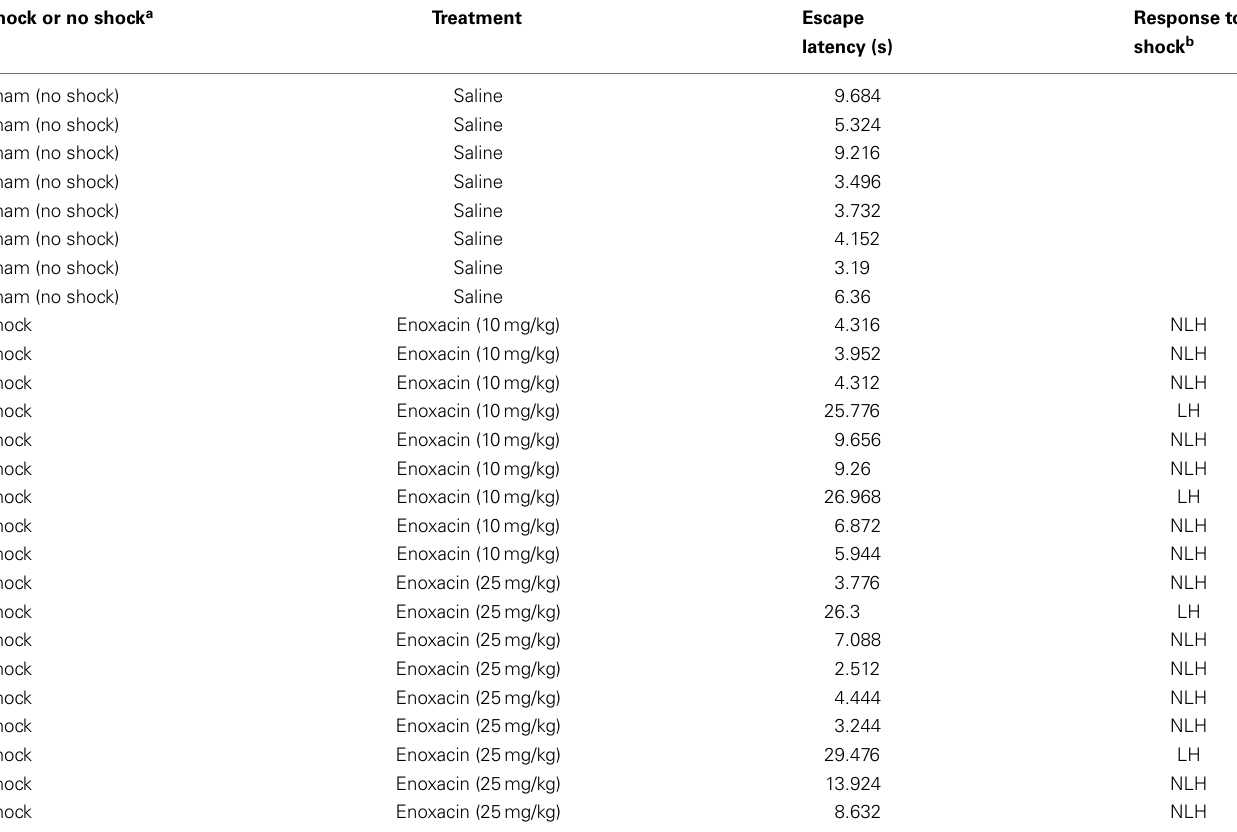
TableA1 | Confirmation experiment in a separate group of rats showing escape latency of individual rats when given no shock or inescapable shock and simultaneously treated with saline or enoxacin (10 or